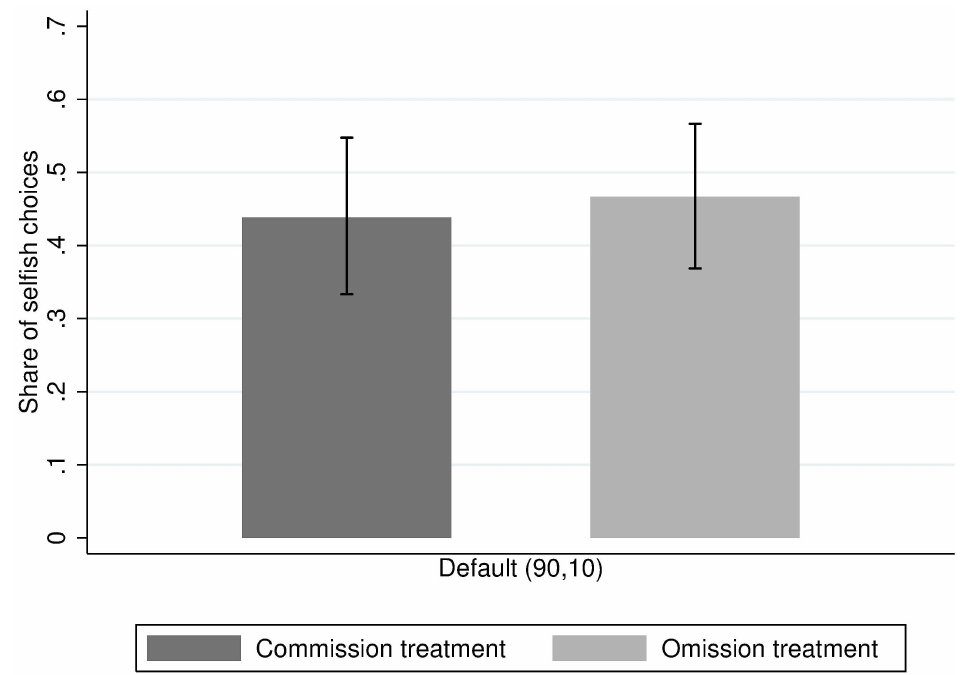
Fig 1. Average share of selfish choices in the first allocation choice with default (90,10).